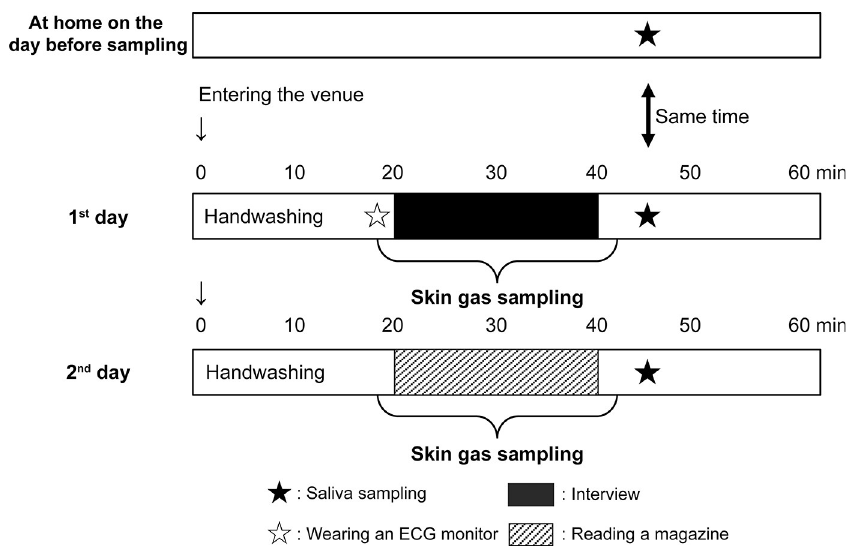
Fig 1. Effects of tension on skin gases. Skin-gas samples were collected from each subject in two situations: under stress (answering questions for 20 min from an interviewer whom they did not know) and at rest (sitting on a chair and relaxing while reading a magazine on a different day). Subjects washed their hands with unscented soap before sampling. The electrocardiographic activity was measured continuously by an ECG monitor (Ledar Circ, Sumitomo Dainippon Pharmaceutical). Saliva samples were collected three times. The first measurement refers to samples collected as a baseline while the subjects were at home resting during the same time frame as that of the interview but on a different day. The second sample was collected after the interview, and the third one was collected after the subjects had read a magazine.